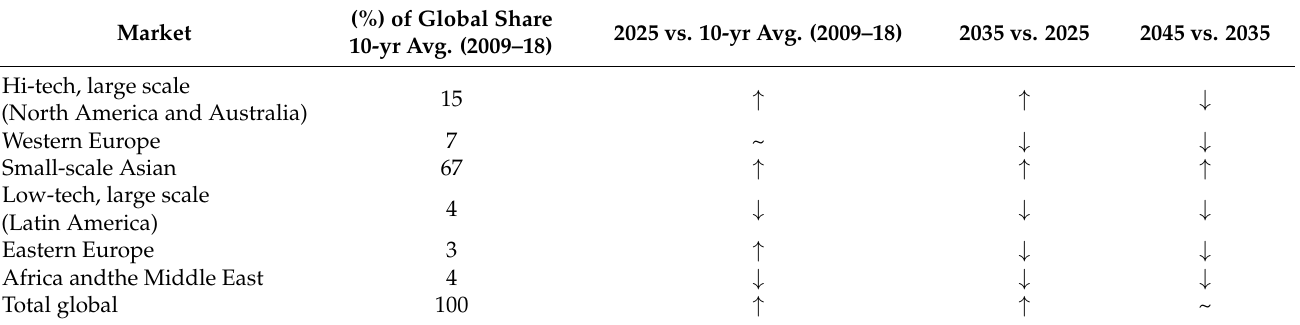
Table 4. Forecast of annual tractor sales until 2050. Reproduced with permission from [66], 2019 Prof. Dr. J.